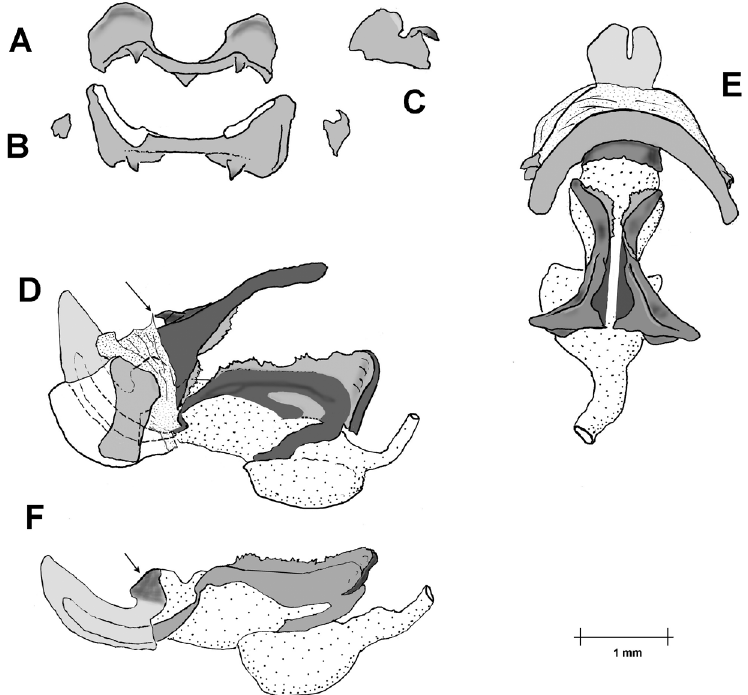
Fig. 3. Aresceutica morogorica , phallus. A. Epiphallus, axial view; B. Epiphallus, and oval sclerites, dorsal view; C. Epiphallus, lateral view; D. Phallic complex after removal of epiphallus, lateral view. The arrow indicates the cut edge of the epiphallic membrane, where the epiphallus was removed; the remaining epiphallic membrane has dropped down behind the zygoma. In the other figures of this series (i.e. Figs 4–6) this membrane has been dissected off; E. As in D, but dorsal view; F. Endophallus and arch. The region where the con- nection between arch and zygoma has been cut is arrowed. The lighter shading indicates the ectophallic aedeagal